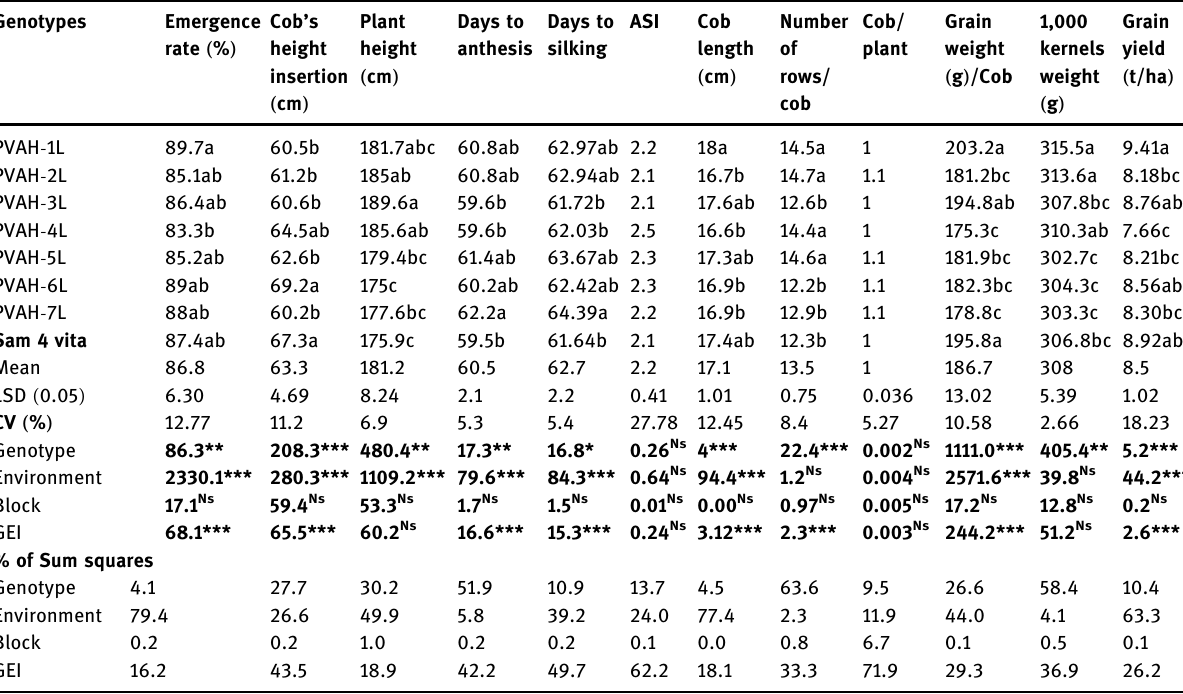
Table 2: Variances of grain yield and other traits including the partitioning of the G × E interaction of provitamin A maize genotypes over six